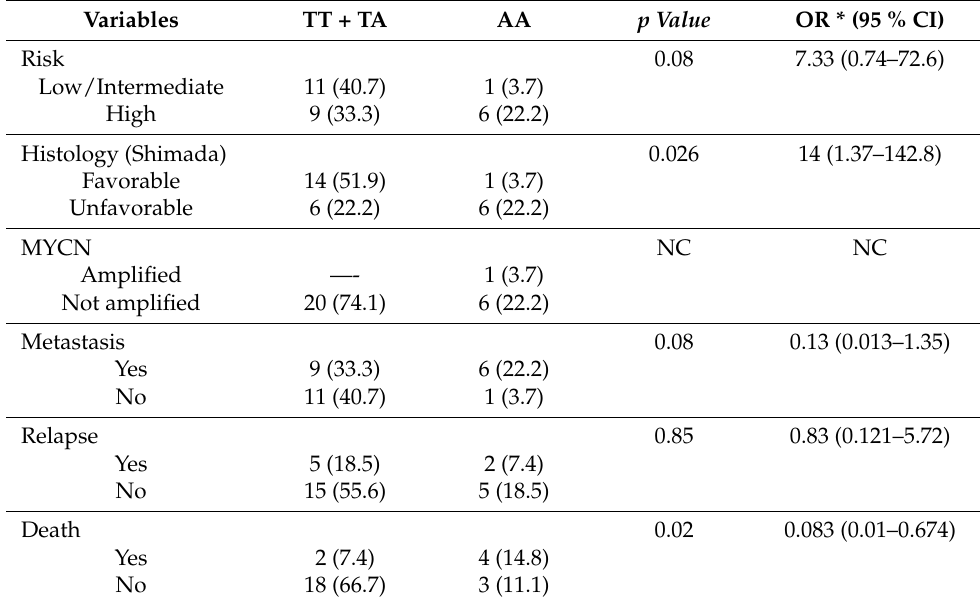
Table 7. Characteristics of NB patients stratified by genotype of the SNP IL-8 − 251 T > A